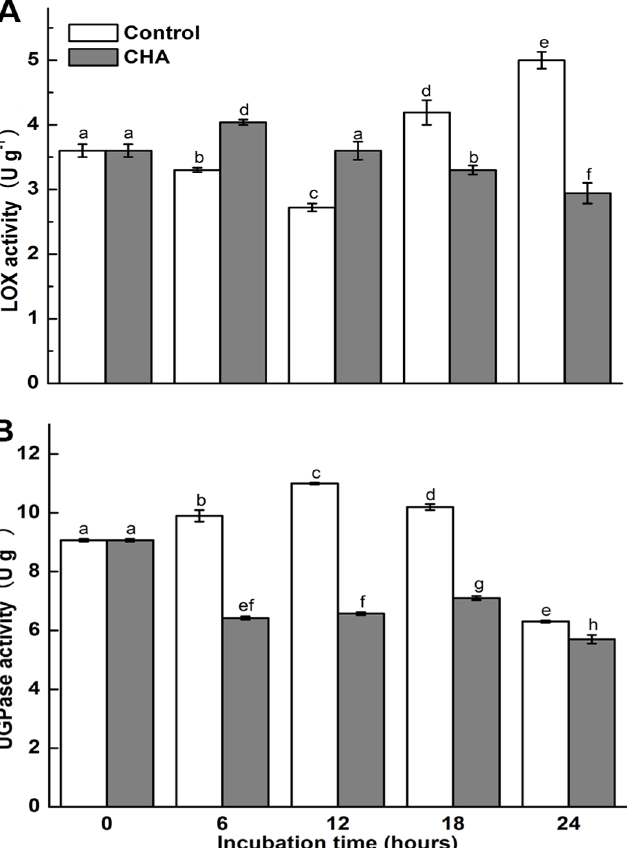
Fig 6. Effects of CHA on activities of lipoxygenase(LOX) and UDP-glucose pyrophosphorylase (UGPase) in apple pulp discs during incubation at 25°C. Each data point represents a mean ± standard deviation (n = 3). Values with different letters are significantly different at p <